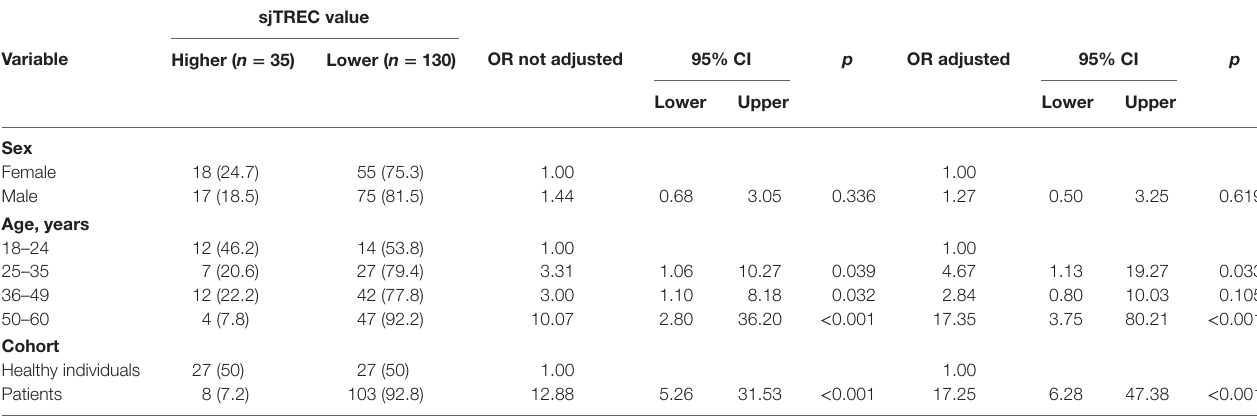
Table 4 | Univariate and multivariate logistic regression analyses with odds ratios (ORs) for low signal joint TREC (sjTREC) copy numbers (lower than the mean sjTREC copy number of 606.55) based on sex, age, and health condition ( n =